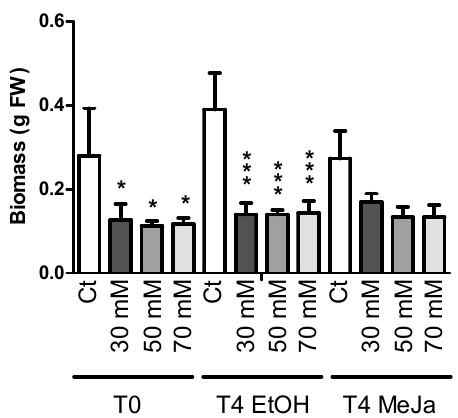
Figure 7. Effect of eliciting treatments on the biomass. The tested MCD concentrations were 0, 30, 50 and 70 mM. One hundred micromoles of MeJA and EtOH 0.1% were applied after 18 days of culture and for four days. Each point represents the mean with standard deviation of three biological replicates. Each value was compared to its corresponding control using ANOVA test (* p < 0.5, *** p < 0.001). Biomasses of different controls were not statistically different.